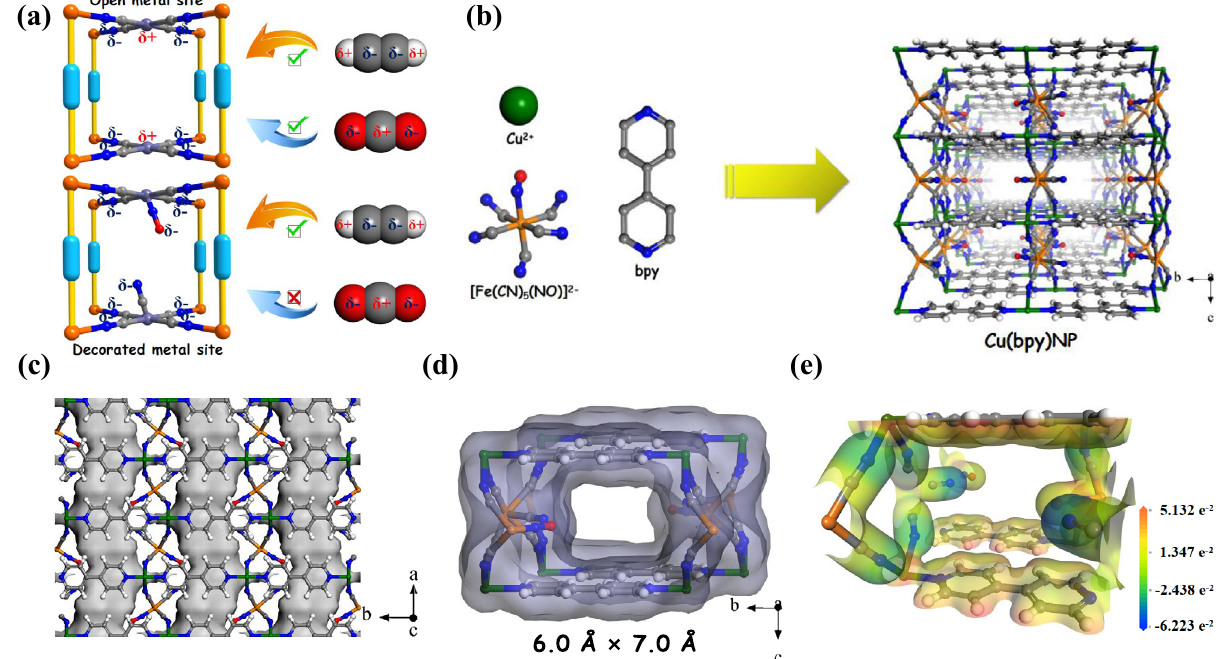
Fig.1|Materialsynthesisandcrystallographicstructures. Schematicillustration of a traditional and nitroprusside-based Hofmann-type MOF networks and b the building blocks (Cu 2+ , [Fe(CN) 5 (NO)] 2 − , and bpy) and the 3D sqc -net topology of Cu(bpy)NP; c viewoftheporechannelsbytheConnollysurfacealongthe ab -plane,